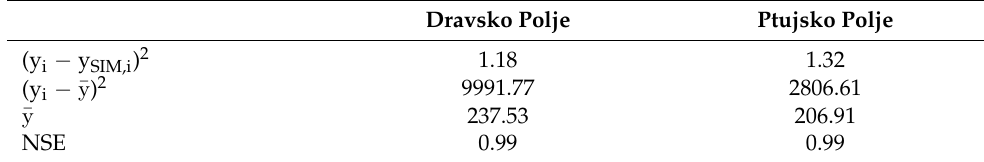
Table 8. Nash–Sutcliffe coefficient of efficiency.